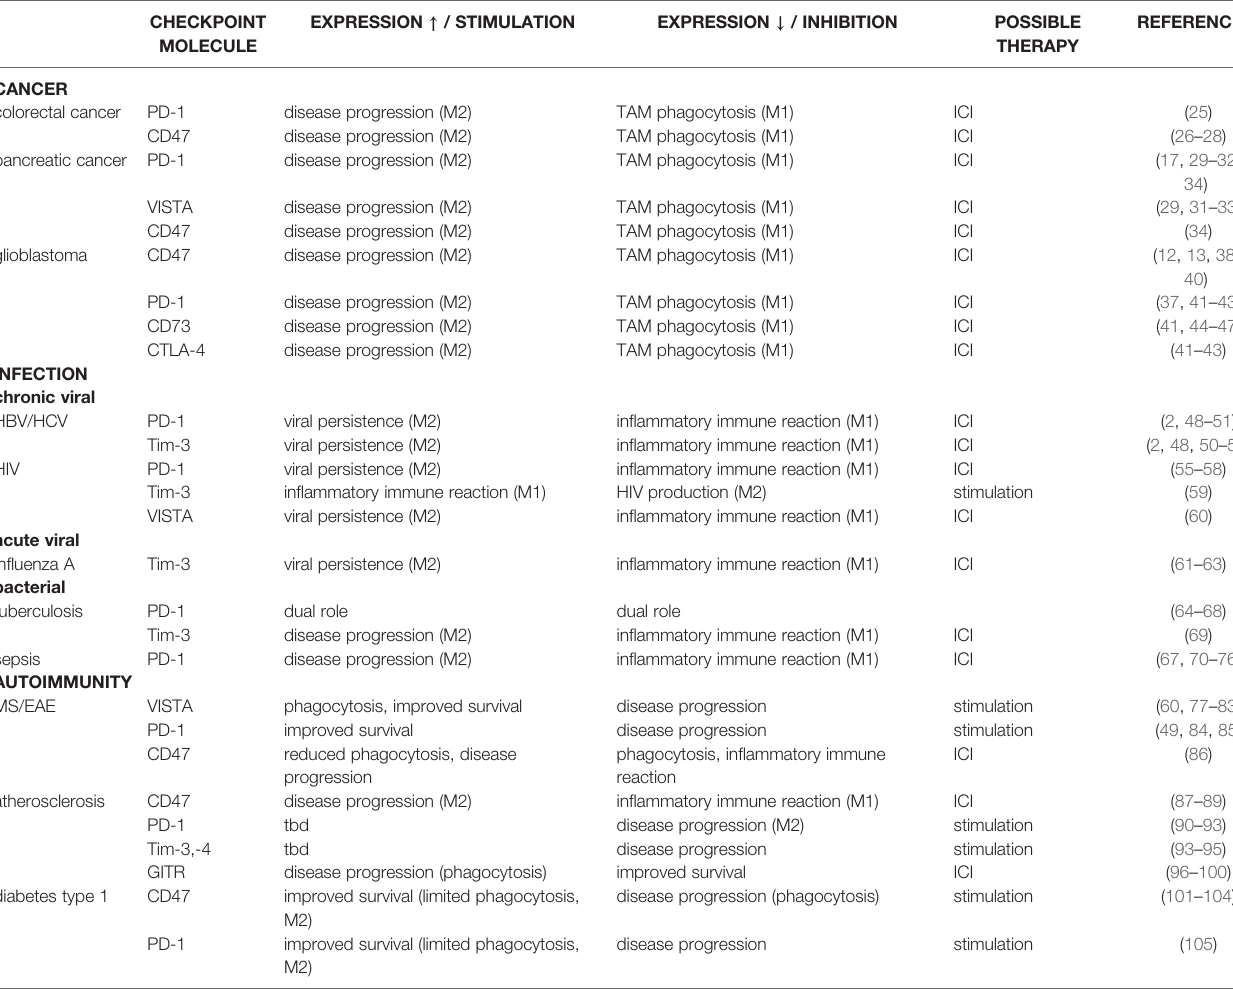
TABLE 1 | Summary of the effects that up- and downregulation of immune checkpoint expression have on macrophage polarity and resulting consequences in malignant, infectious, and autoimmune diseases following up- or downregulation of immune checkpoint expression. CHECKPOINT